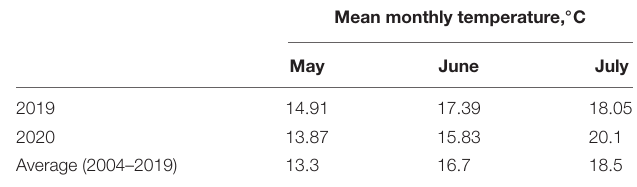
TABLE 2 | Temperature regime in 2019–2020 cropping